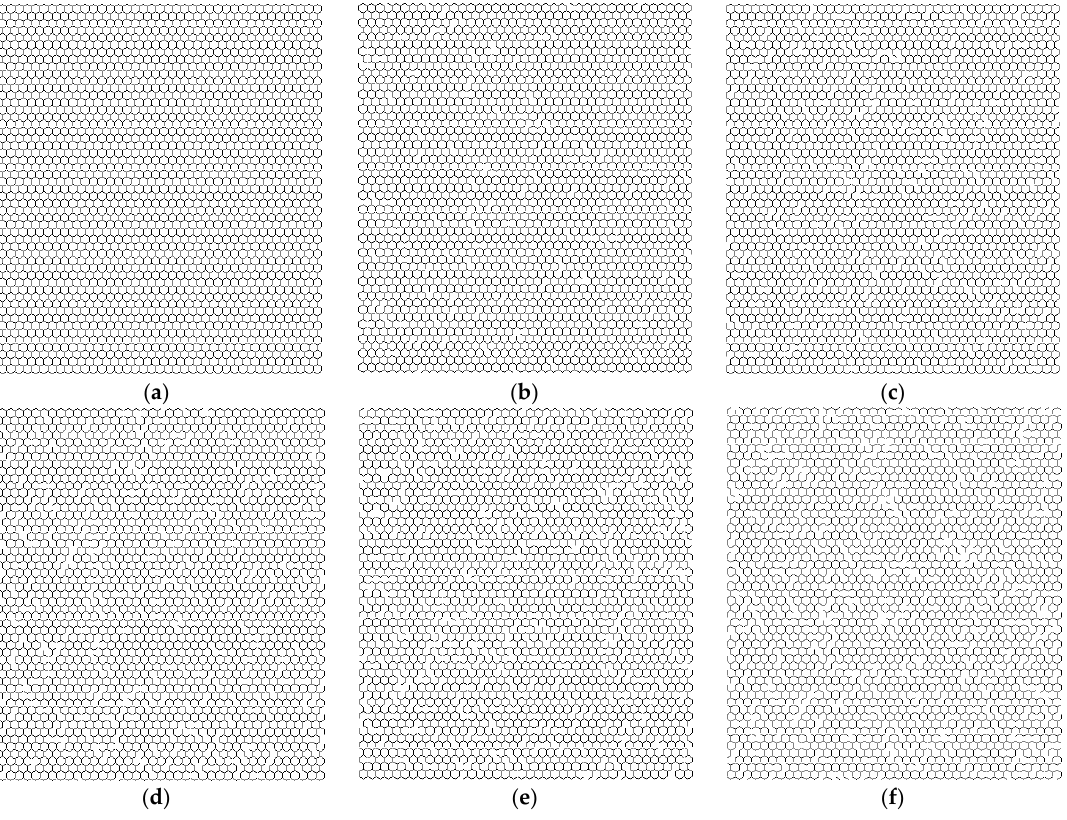
Figure 2. Specific examples of the graphene sheets with vacancy defects. The samples ( a – f ) have 0%, 2%, 4%, 6%, 8%, and 10% of vacancy defects, respectively.